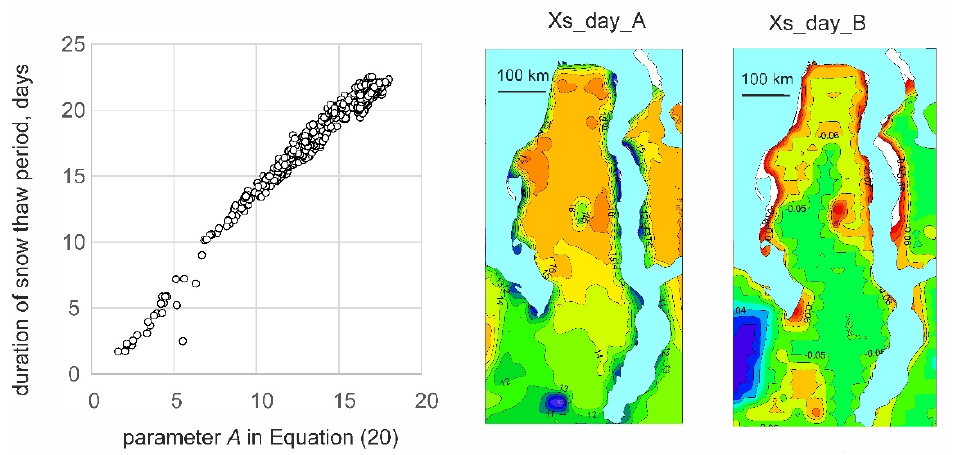
Figure 24. The relationship between parameter A and duration of snow show period ( left ) and spatial distributions of parameters A and B in Equation (20).